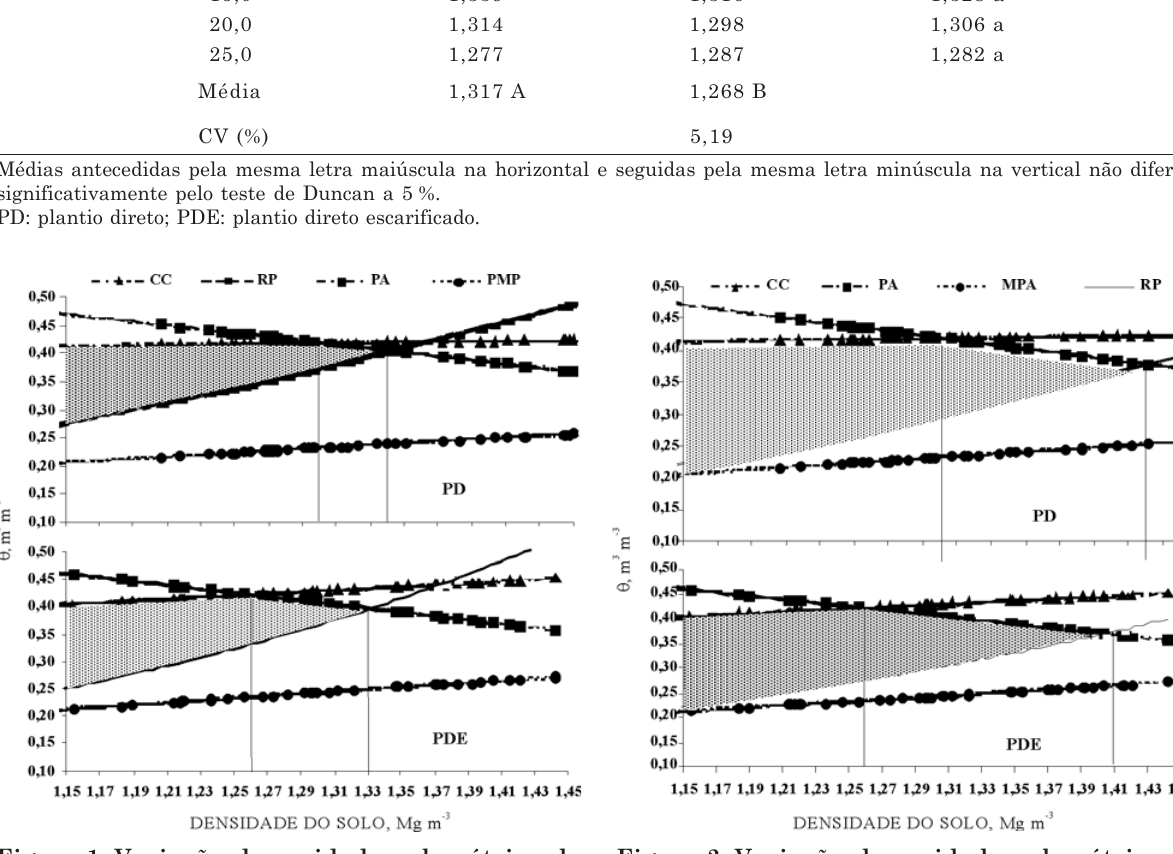
Figura 2. Variação da umidade volumétrica de acordo com a densidade do solo para os níveis críticos de capacidade de campo na tensão de 6 kPa (CC), porosidade de aeração de 10 % (PA), ponto de murcha permanente (PMP) na tensão de 1.500 kPa e resistência mecânica do solo à penetração de 3 MPa (RP). A área hachurada representa o